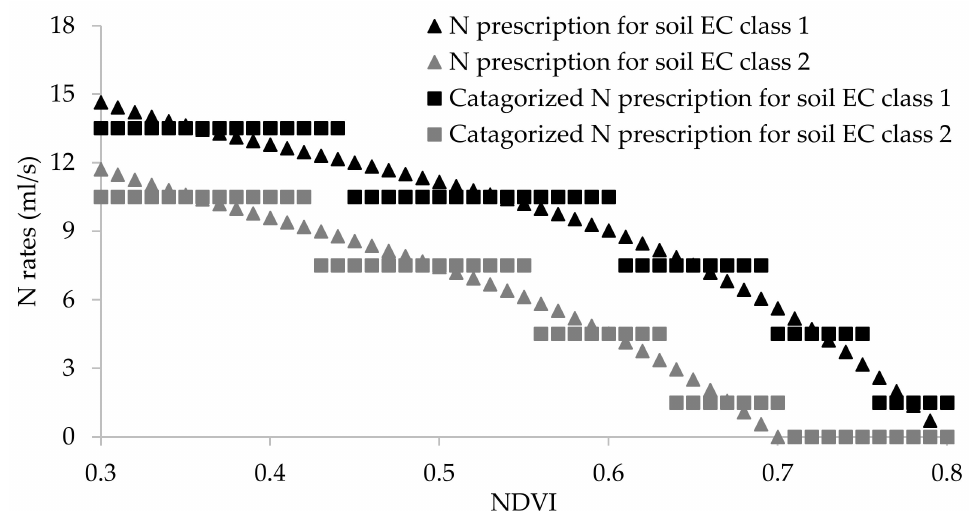
Figure 9. Controller–calculated N rates for soil EC classification 1 (black triangles) and soil EC classification 2 (grey triangles) and the controller-categorized N rates for soil EC classification 1 (black squares) and soil EC classification 2 (grey squares) vs. controller-recorded NDVI values. The average application rates for each rate classification of 0, 1.5, 4.5, 7.5, 10.5, and 13.5 mL/s were − 10.107, 1.328, 4.433, 7.472, 10.622, and 29.329 mL/s for the soil EC classification 1. The average application rates for each rate classification of 0, 1.5, 4.5, 7.5, 10.5, and 13.5 mL/s were − 14.024, 1.529, 4.644, 7.625, 11.477, and 33.279 mL/s for the soil EC classification